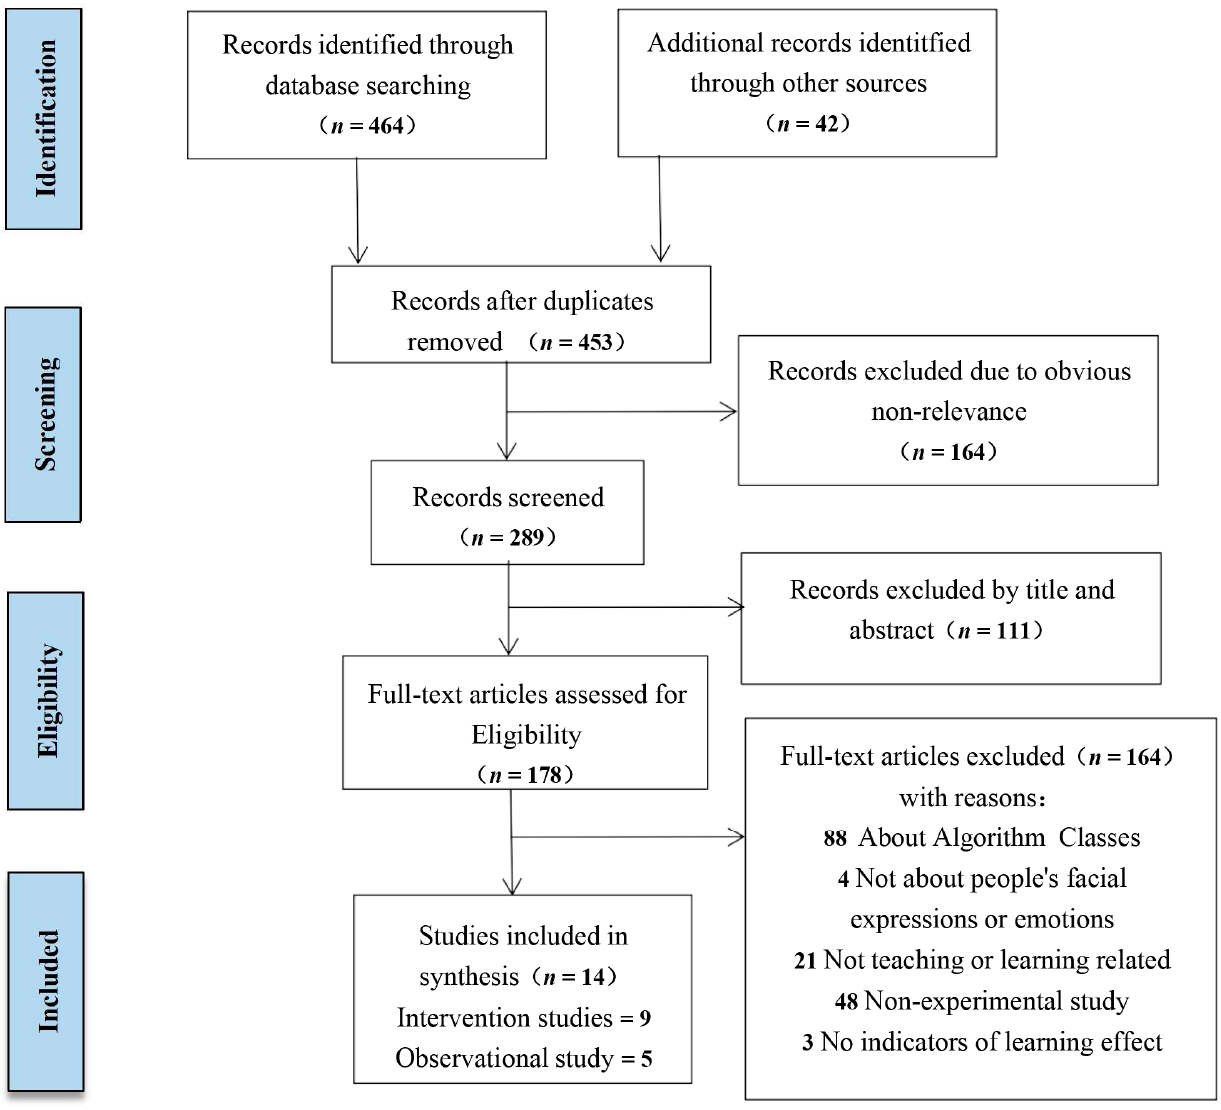
Figure 1. Research screening flowchart.